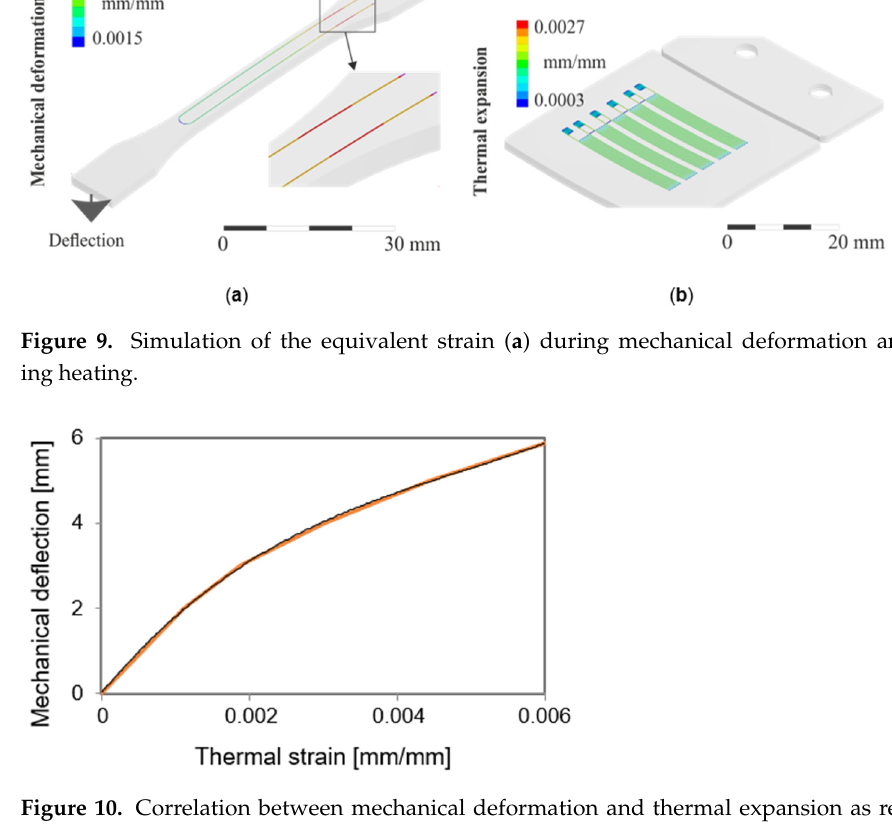
Figure 8. Number of cycles dependent on the deflection and ( a ) the thickness of the nickel layer, whereas the roughness R a was 1.9 µm; ( b ) the phosphorous content in the nickel layer, whereas the roughness R a was 6.5 µm and nickel thickness was 3 µm.